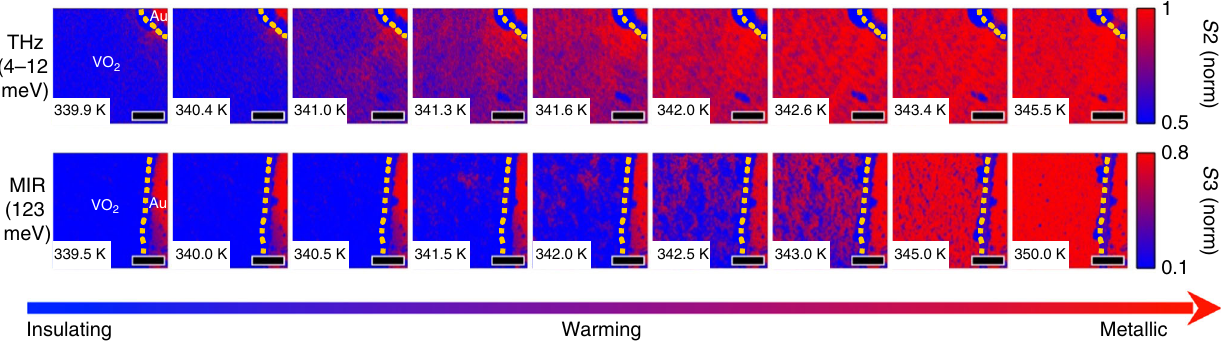
Fig. 2 SNOM images of the VO 2 IMT. The images shown are taken at THz (top row) and MIR (bottom row) frequencies during a heating cycle. The temperature of each image is noted in the bottom left corner. In all images, the signal at every temperature is normalized to the average signal obtained on gold (bright red region in the upper right or right of the image, for THz and MIR respectively). The dashed yellow line denotes the boundary between VO 2 and gold regions. The THz and MIR data are S 2 and S 3, which is the detected signal demodulated at the second and third harmonic of the tip tapping frequency, respectively. Low near- fi eld signal (blue) is measured in insulating regions, while high near- fi eld signal (red) corresponds to a metallic state. The scales are different for the THz and MIR images to highlight the transition from insulator to metal in both cases. Scale bar, 2 μ m